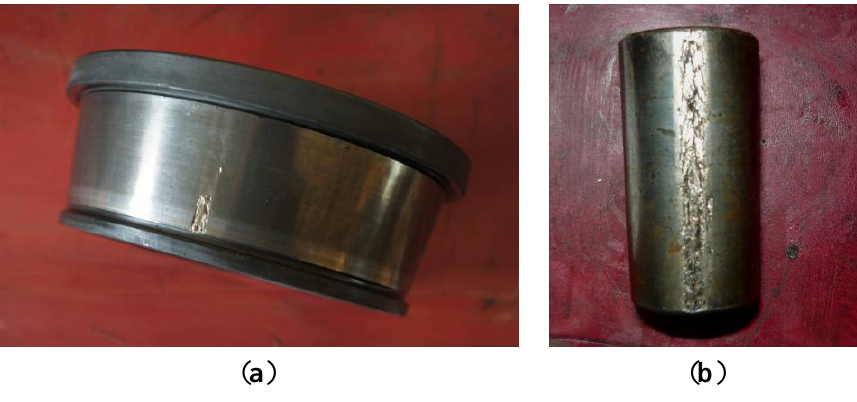
Figure 18. ( a ) Inner race fault; ( b ) Roller fault.